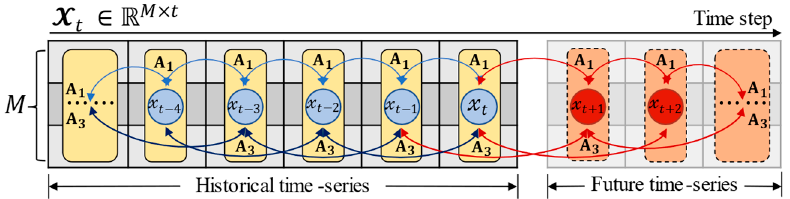
Figure 1. Illustration of multivariate time series forecasting (each 𝔁 (cid:3047) is a frame of traffic data at time step 𝑡 ).